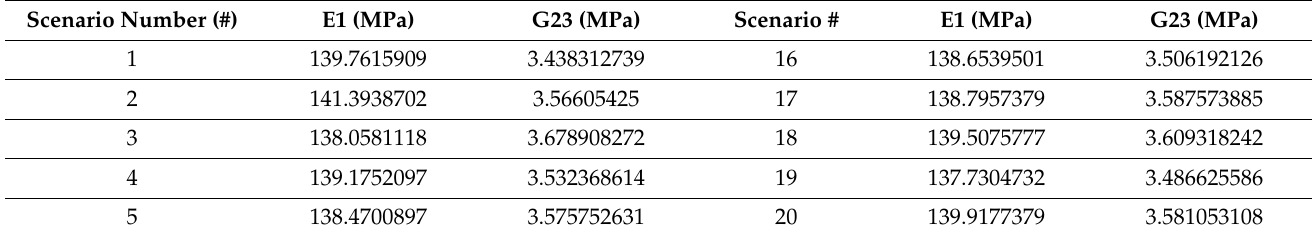
Table A1. Latin hypercube sampling scenarios with E1 and G23 as input